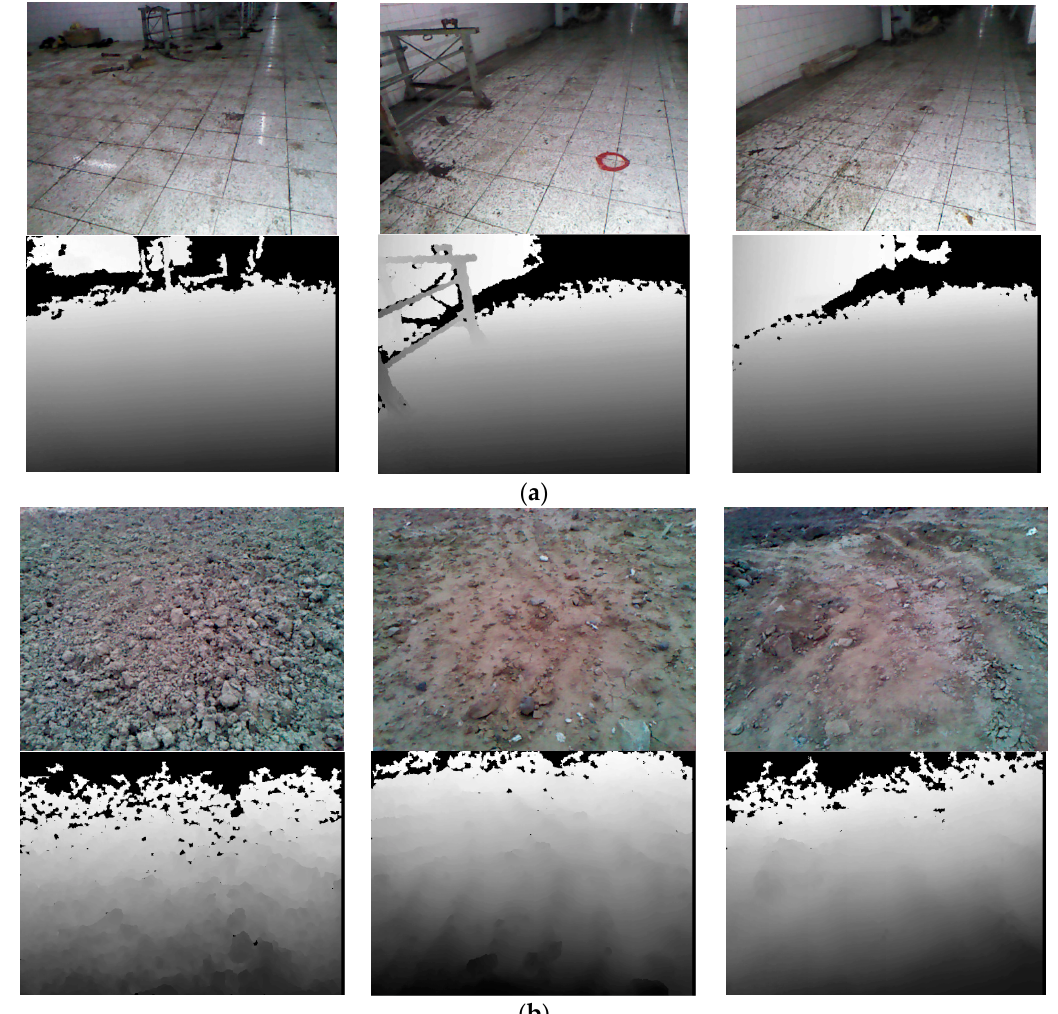
Figure 6. Typical RGB images and corresponding depth images acquired in two experiments. ( a ) Typical images acquired in a tunnel in Experiment I; ( b ) Typical images acquired in an outdoor field in Experiment II. Images in the first row were captured by the RGB camera, and images in the second row were captured by the depth camera. The areas, which are out of the imaging range (0.5 m to 4 m) or without reflected infrared light, are shown in black in the depth images. The middle image of the first row in (a) shows one of the control points (inside the red circle).